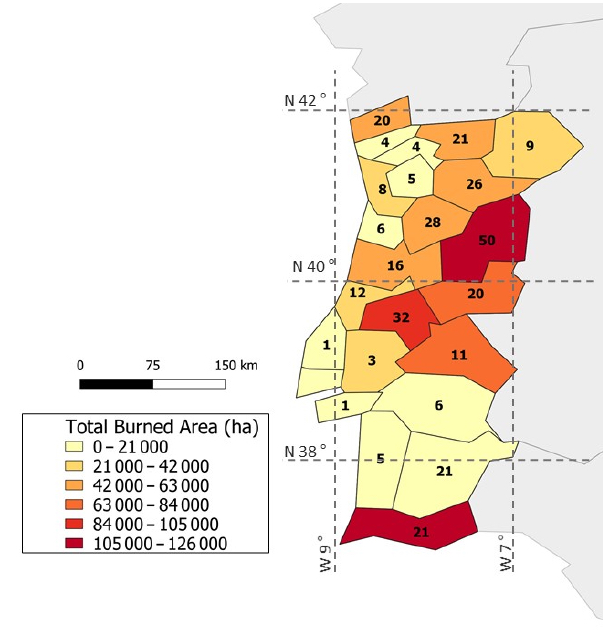
Figure 2. Total burned area per NUTS III region from June to September in the period 2001–2016. The numbers inside each NUTS III region represent the respective number of large fires ( > 1000ha) in the same